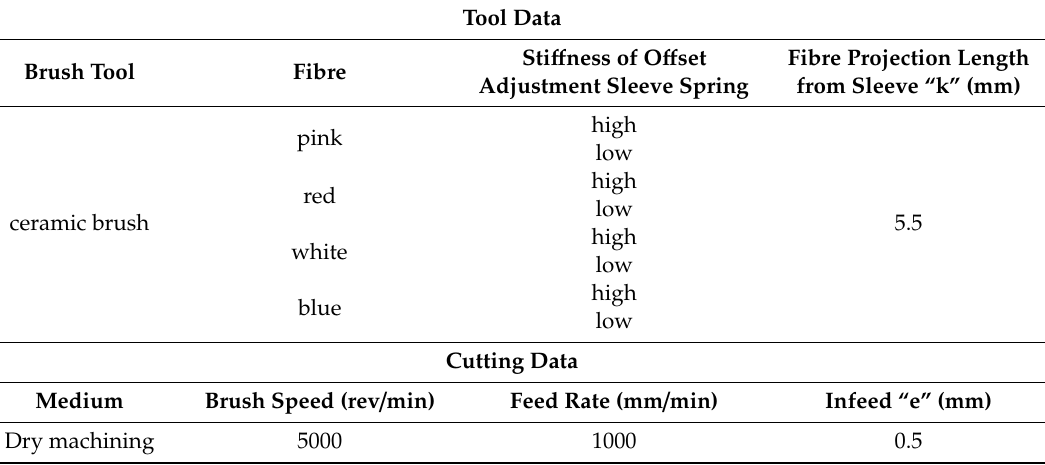
Table 2. Brushing conditions.